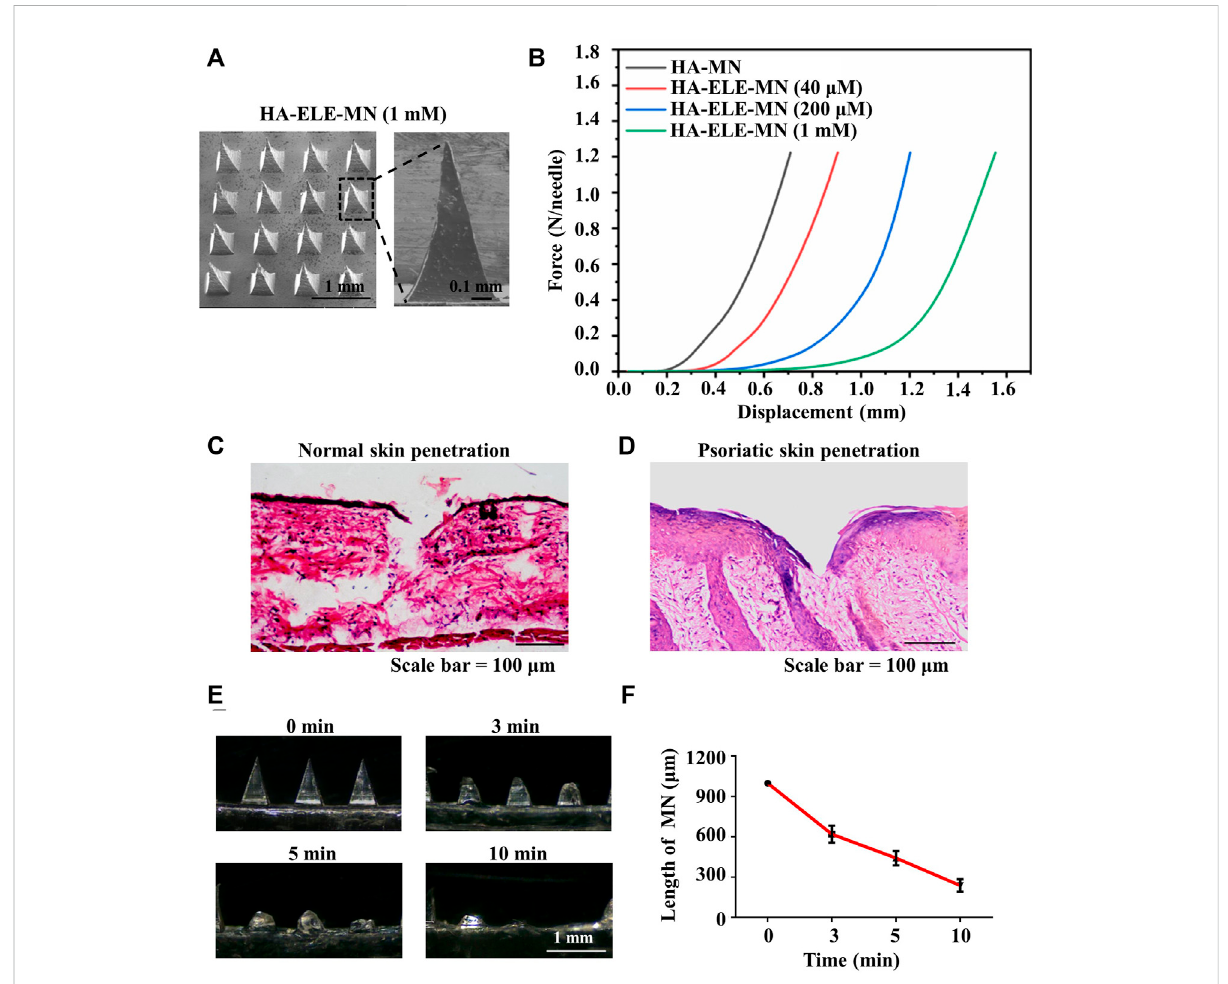
CharacterizationsofHA-ELE-MN(1mM). (A) MorphologyofHA-ELE-MN(1mM)recordedusingSEM. (B) Force-displacementcurvesofHA-ELE- MNscontainingdifferentconcentrationsofELE. (C) H&EstainingofnormalbackskinofBALB/cmiceafterapplicationofHA-ELE-MN(1mM). (D) H&E staining of psoriasis skin of IMQ-induced psoriasis BALB/c mice after application of HA-ELE-MN (1mM). (E) Dissolution of HA-ELE-MN (1mM) in the skin of BALB/c mice. (F) Quantitative analysis of the speed of in vivo drug release by measuring the change of needle